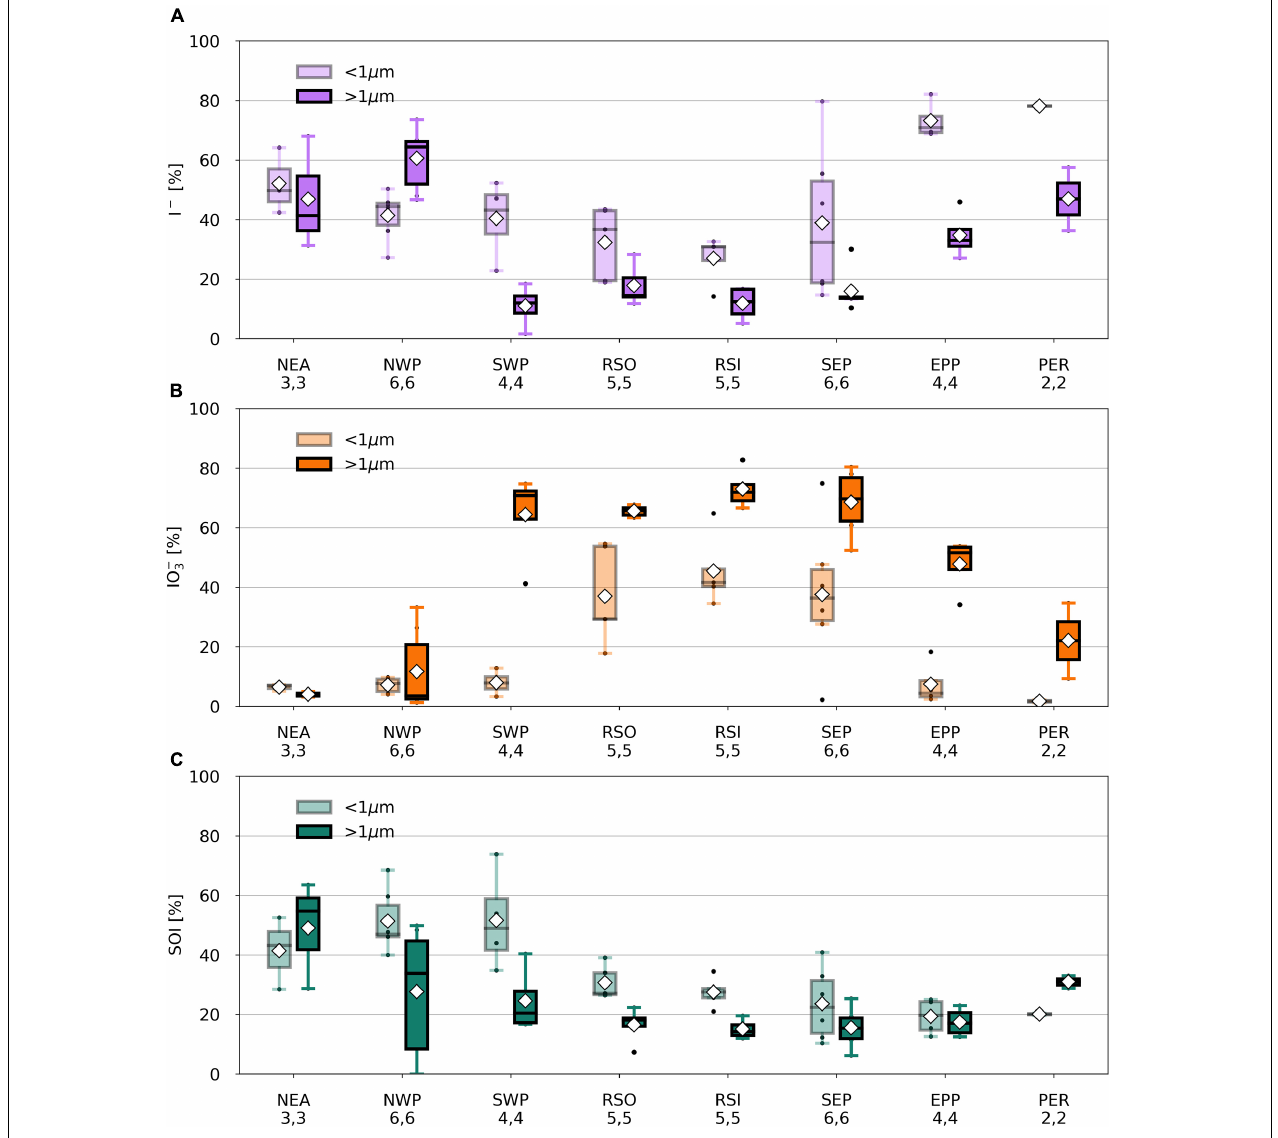
FIGURE 5 | Percentage I - (A) , IO 3 - (B) , and SOI (C) of TSI in fine (light) and coarse (dark) mode aerosol samples per air mass type from TransBrom, OASIS, and M138. SOI concentrations for which the error is larger than the parameter itself are omitted. Black dots represent individual samples. White diamonds show the average value. Lower (upper) whisker extends to the sample that is within 1.5 × interquartile range lower (higher) beyond the first (third)